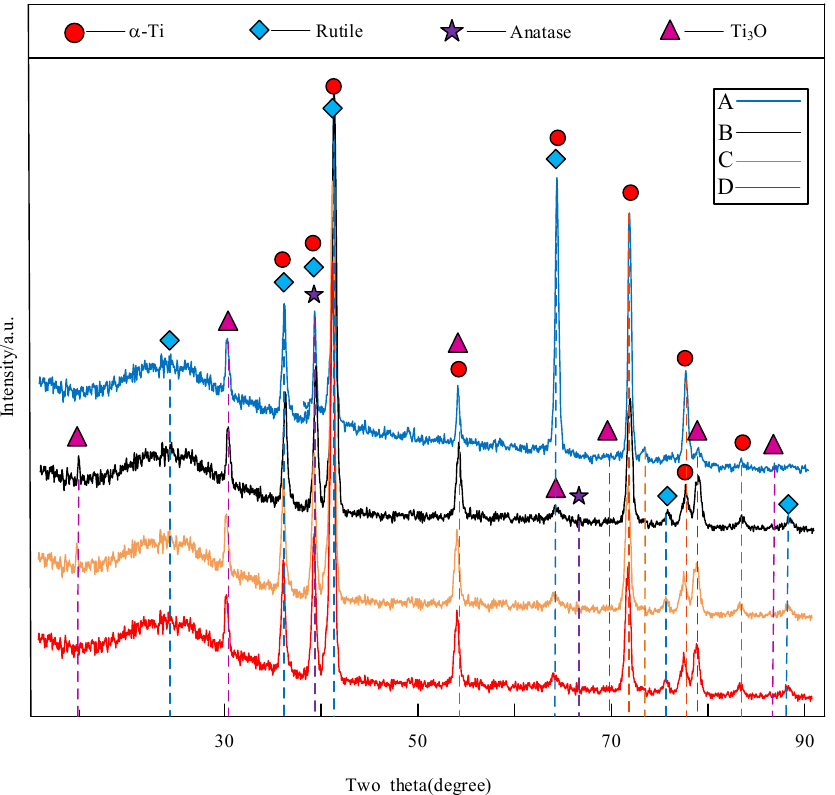
Figure 8. XRD patterns of PEO coatings: Substrate roughness of (A) 3.2, (B) 1.6, (C) 0.8, and (D) 0.2 µm.